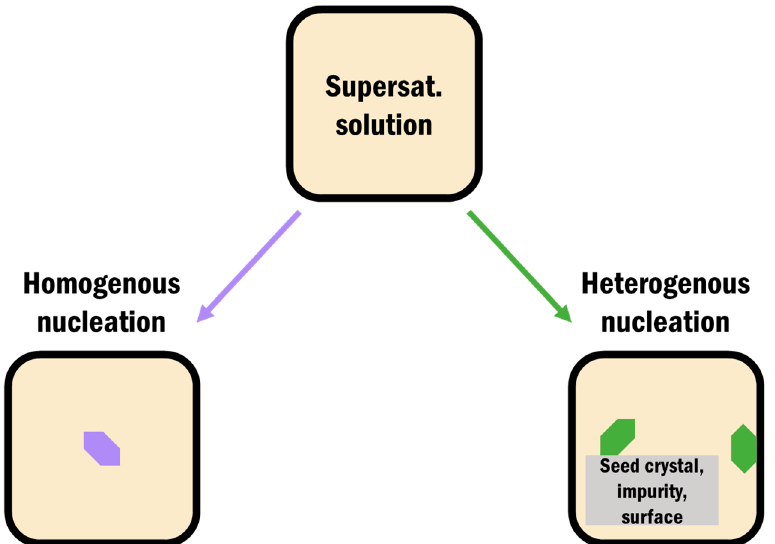
Figure 3. Schematic representation of homogeneous nucleation directly out of a supersaturated solution and heterogeneous nucleation from a container surface, added impurity, or seed crystal.